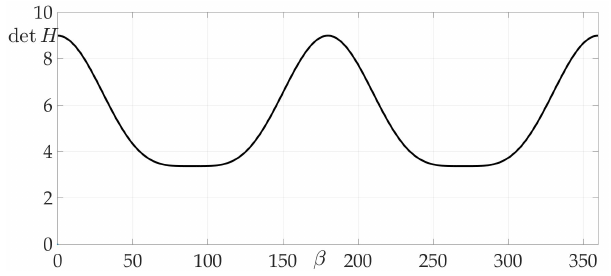
Figure 5. Dependence of Hessian det H from β .